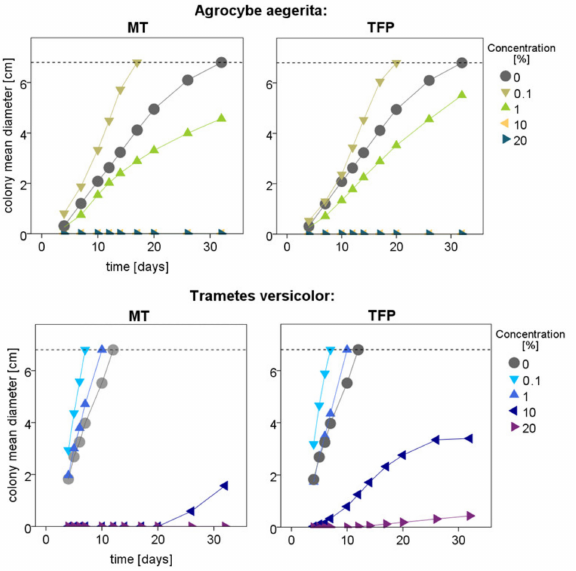
Figure 5. Mean mycelium diameter without the initial plug in cm of the two fungi during the 32 days of